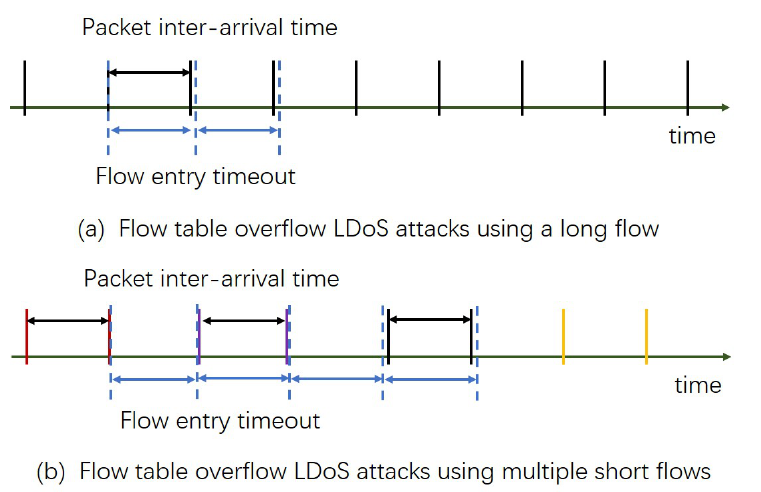
Figure 3. Flow table overflow LDoS attacks in SDN